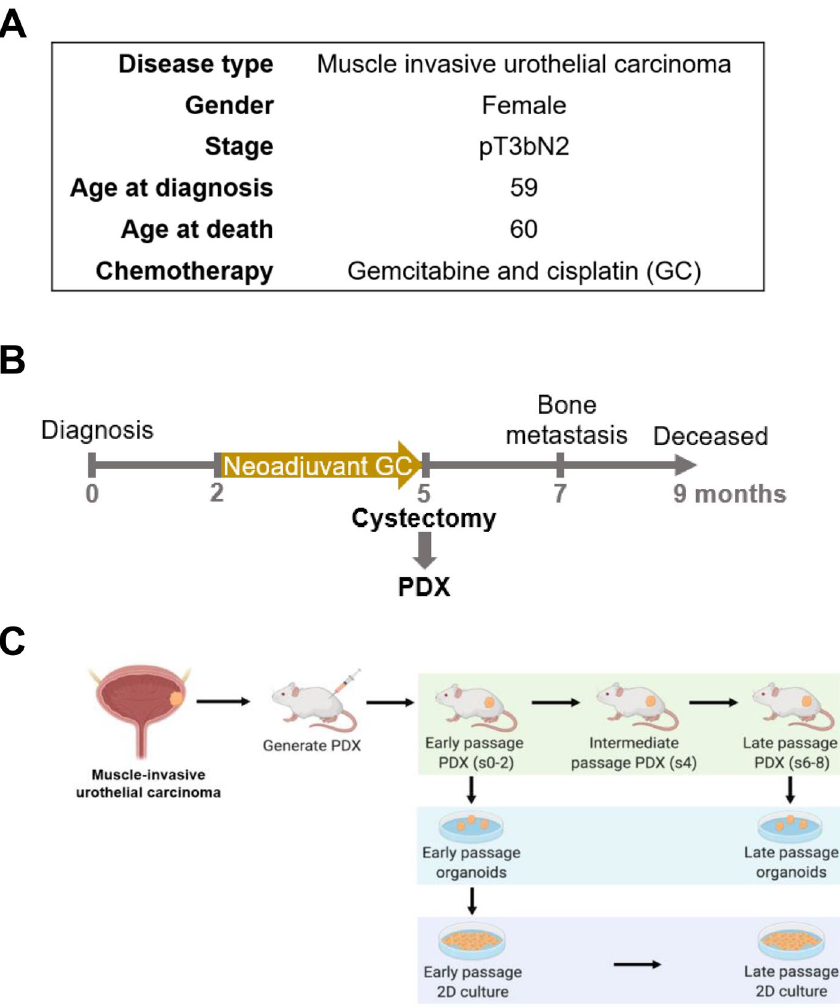
Figure 1. CoCaB 1 PDX patient characteristics. ( A ) Clinical information of the patient. ( B ) Timeline and clinical course of the disease. ( C ) Experimental design to establish laboratory models, created with Biorender.